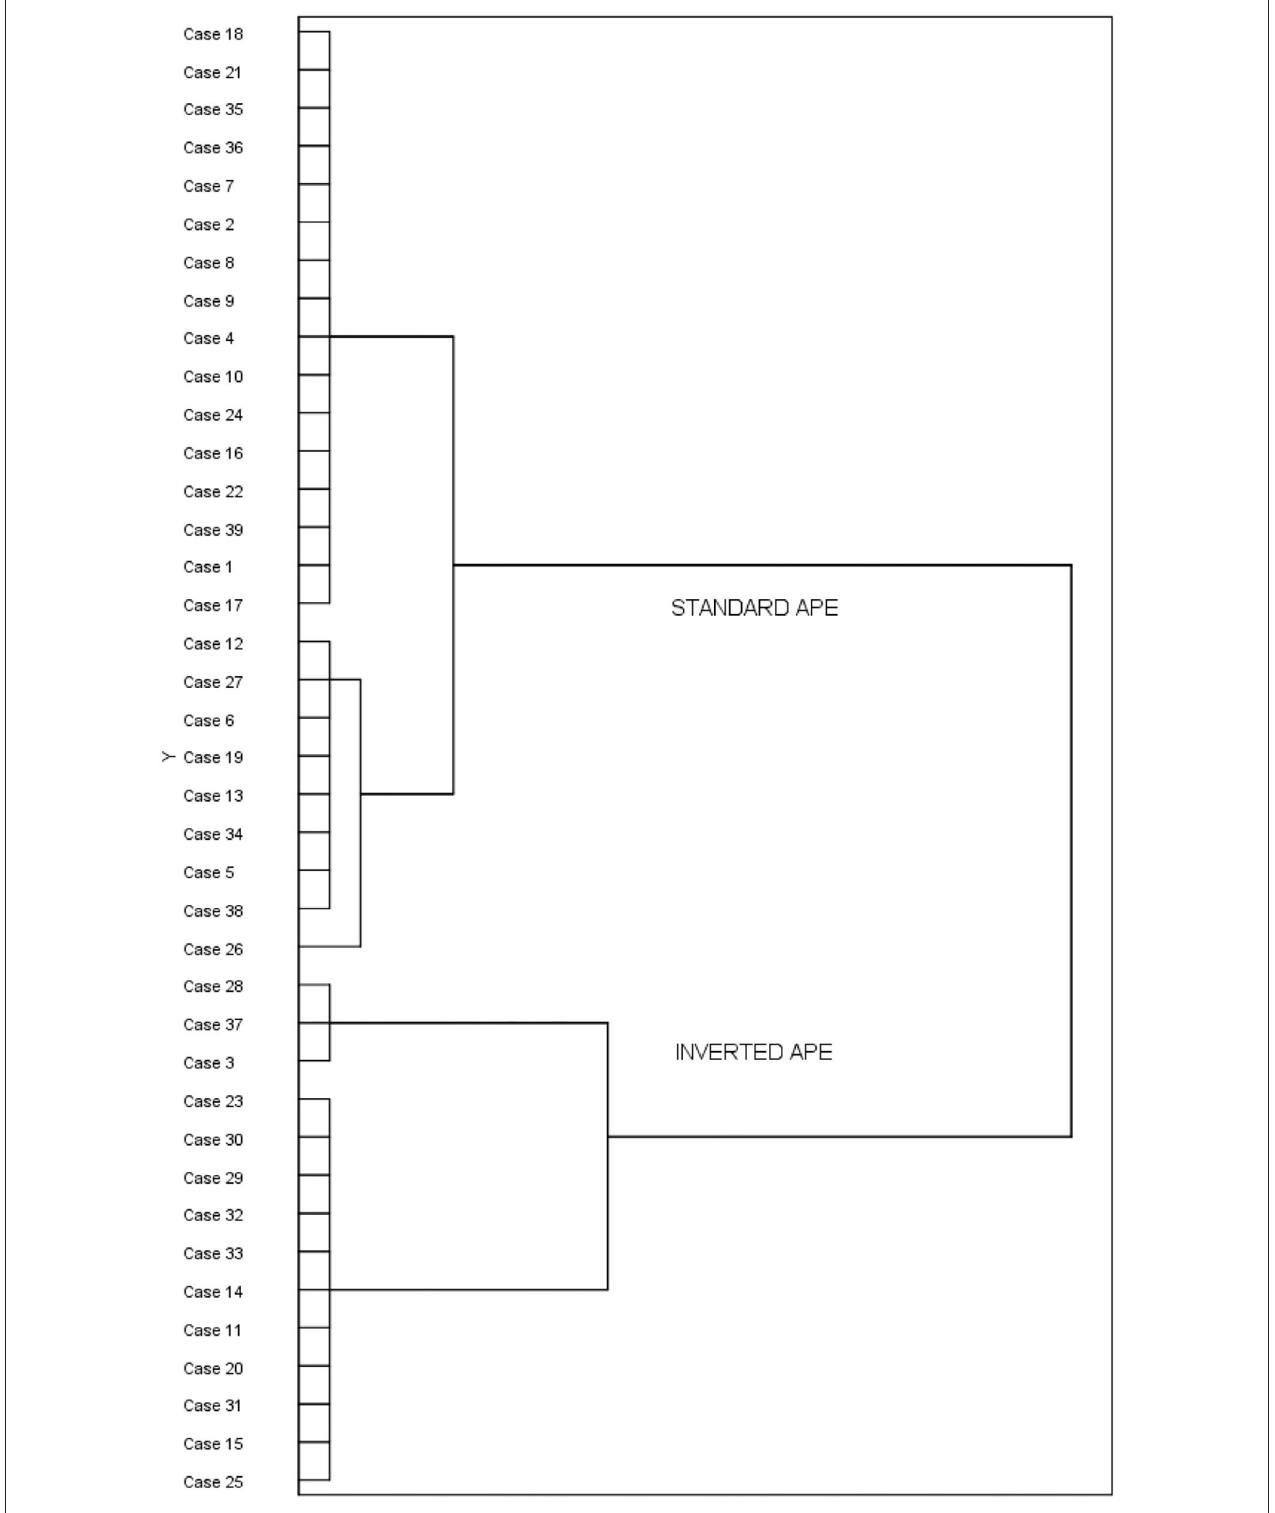
FIGURE 2 | The dendrogram of hierarchical cluster analysis. Cases represent